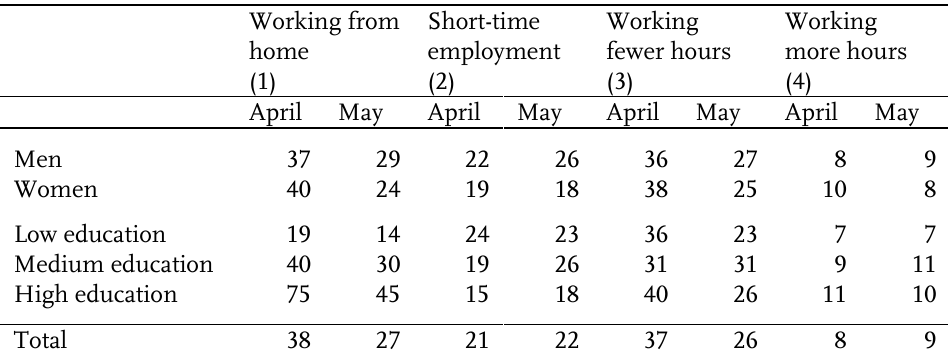
Table 1 : Employment characteristics by gender and level of education (in %), April and